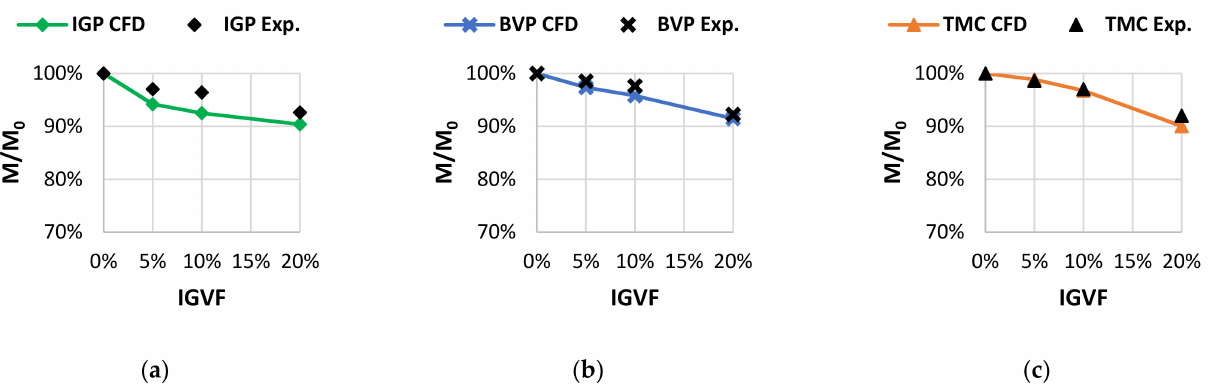
Figure 29. Required driving torques while increasing the IGVF at p 2 = 5 bar pressure load, 20 ◦ C oil temperature and 2000 rpm for the ( a ) IGP, ( b ) BVP and ( c ) TMC pump.